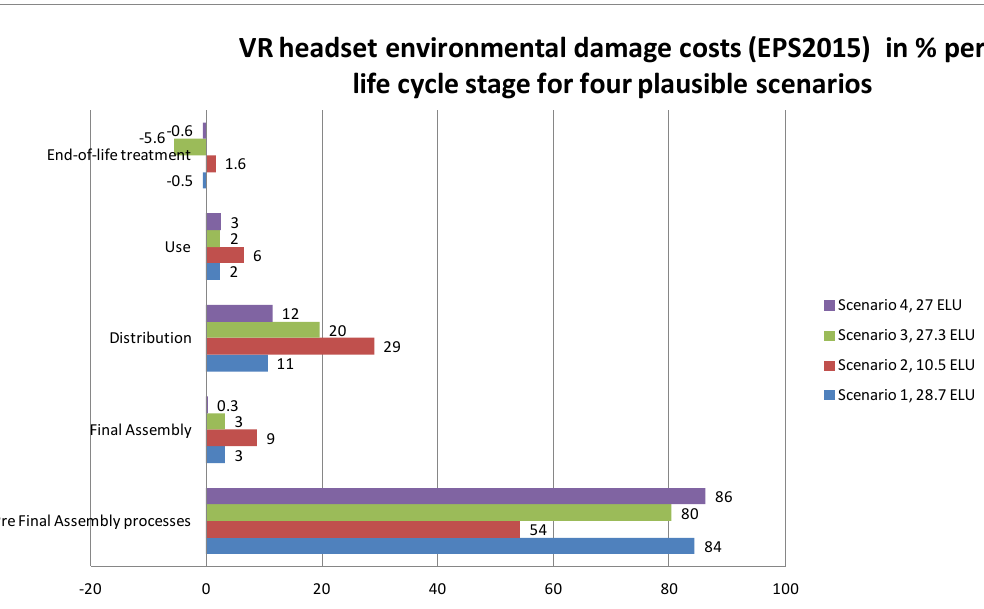
Figure 3. Screening LCA results (EPS2015) for the VR headset for Scenarios 1–4.